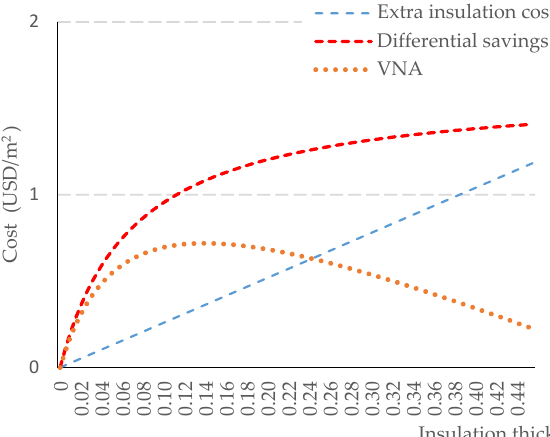
Figure 3. Economic analysis.